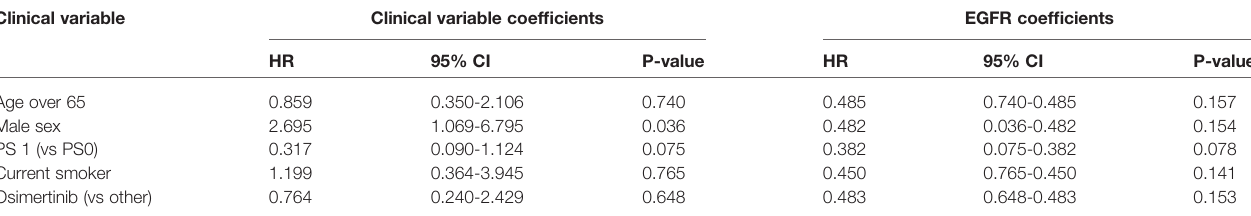
TABLE 1C | Bivariable OS.